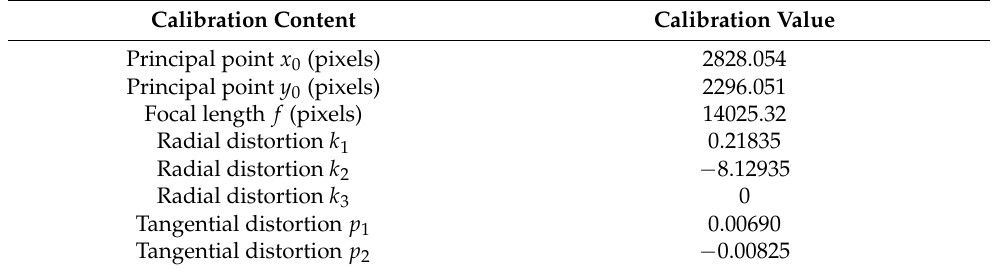
Table 2. Camera calibration parameters.